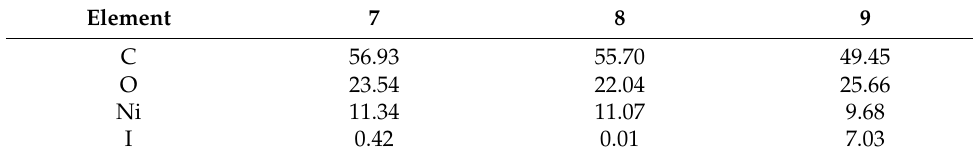
Table 4. Average weight (%) from EDX for complexes 7 – 9